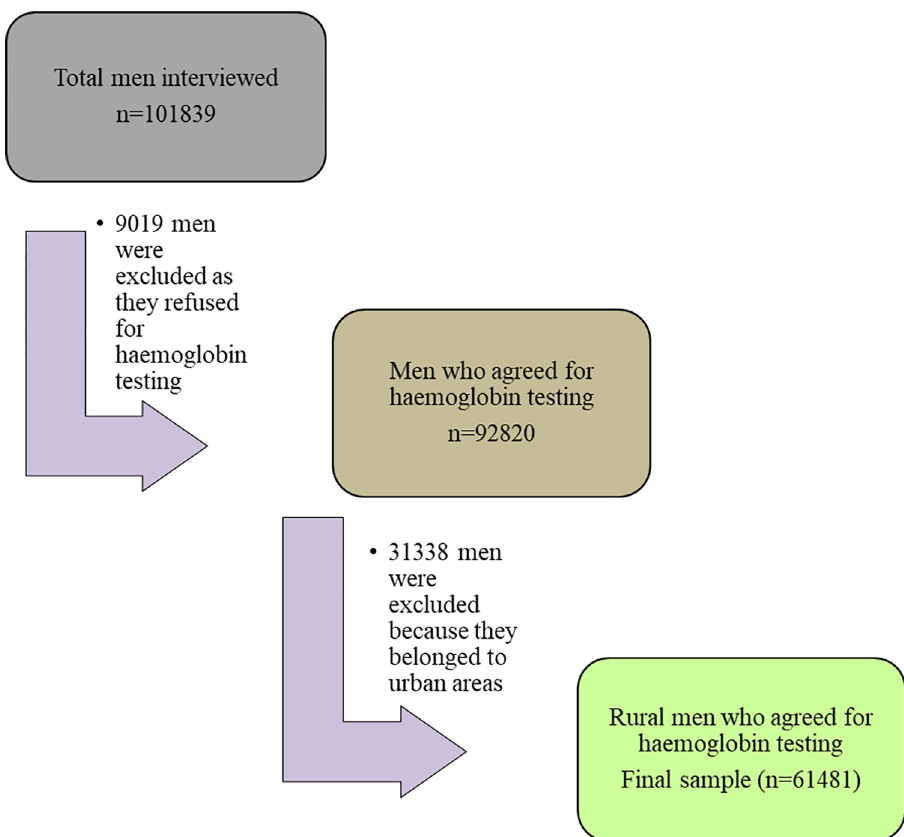
Fig 1. Sample selection for the present